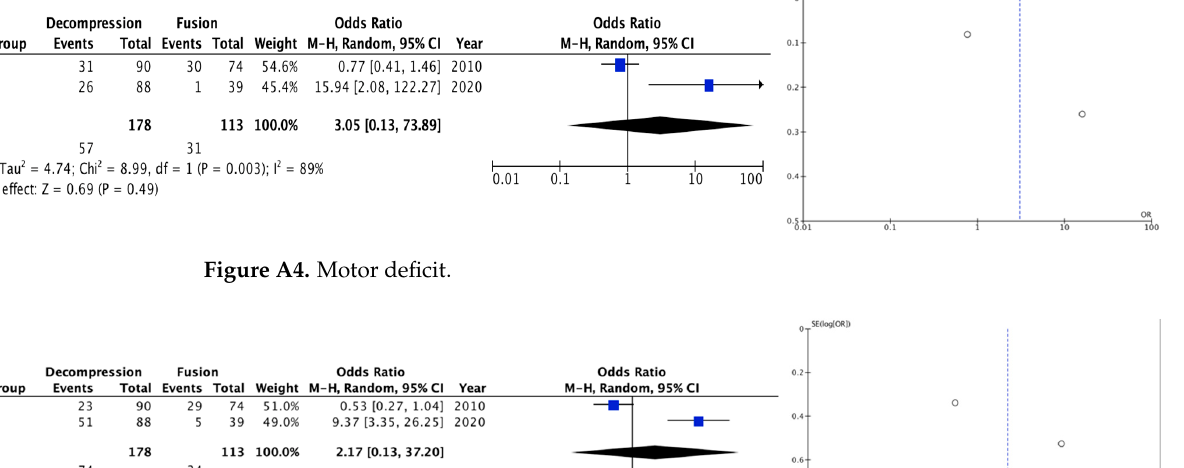
Figure A3. Radiculopathy.